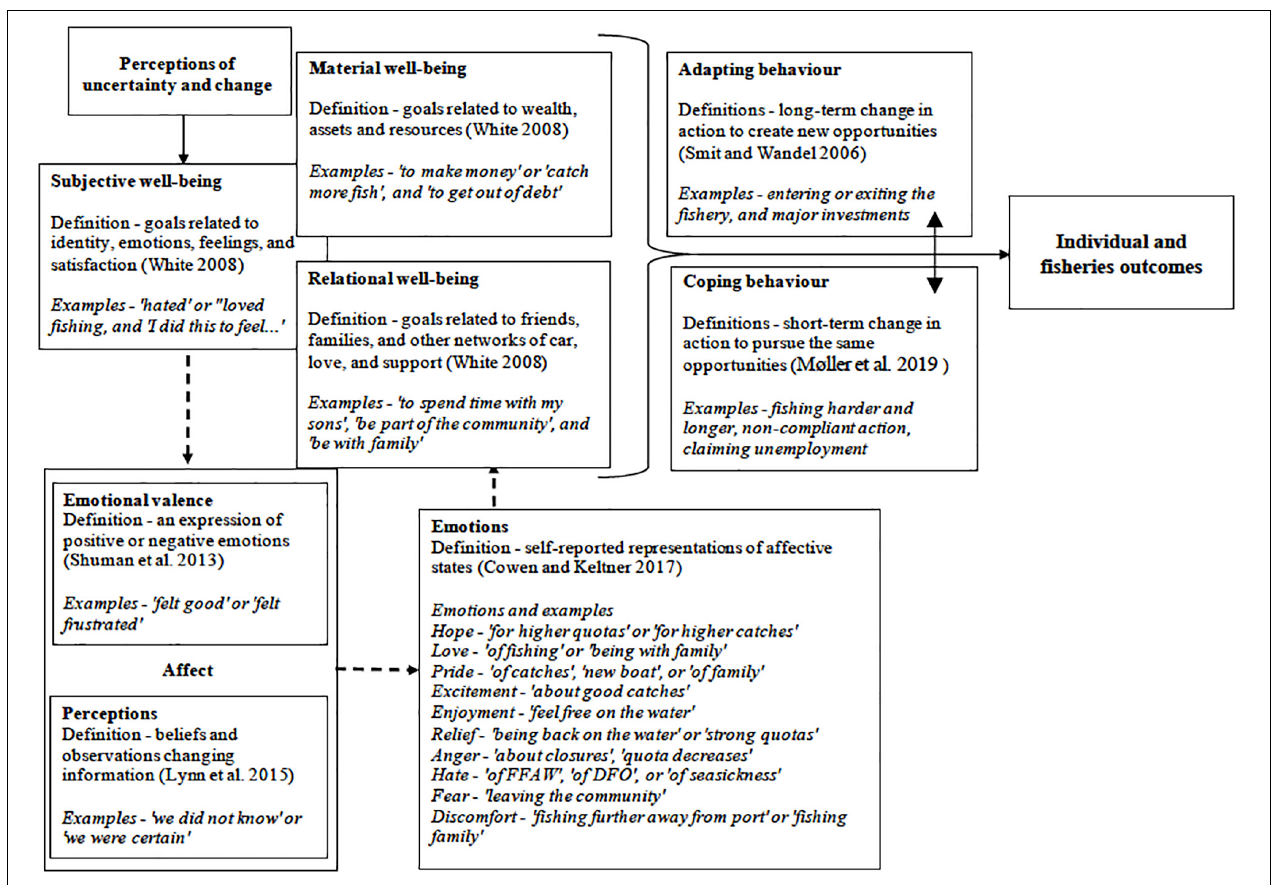
FIGURE 3 | Variables, operational definitions, and example codes (dashed arrows reflect conceptual relationships from emotions research and solid arrows reflect contributions livelihood research).